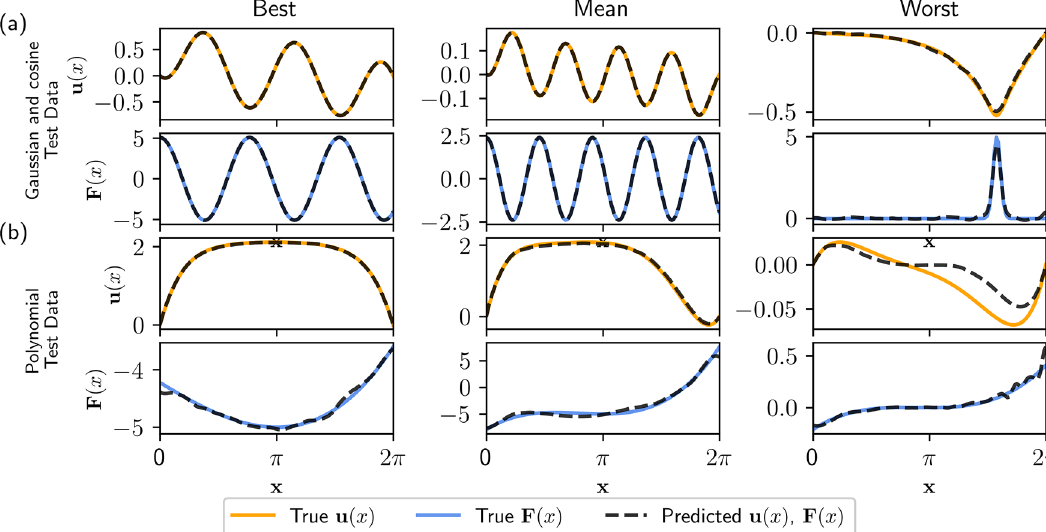
Figure 6. Model predictions on test data. The top row shows the true solution u k ( x ) and the solution predicted by the network given the forcing F k ( x ) using the Green’s function G . The bottom row shows the true forcing function F k ( x ) compared to the forcing computed by applying the operator L to the solution u k . Three columns show the best, mean, and worst case samples as evaluated by the sum of normalized ℓ 2 reconstruction